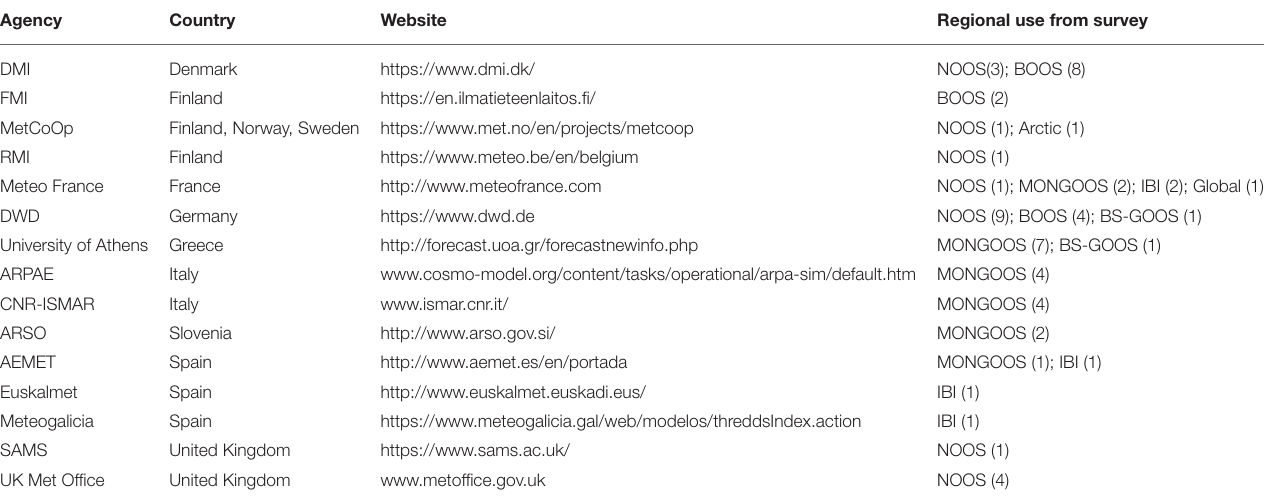
TABLE 3 | Reference website of national providers of local atmospheric forcing mentioned in the